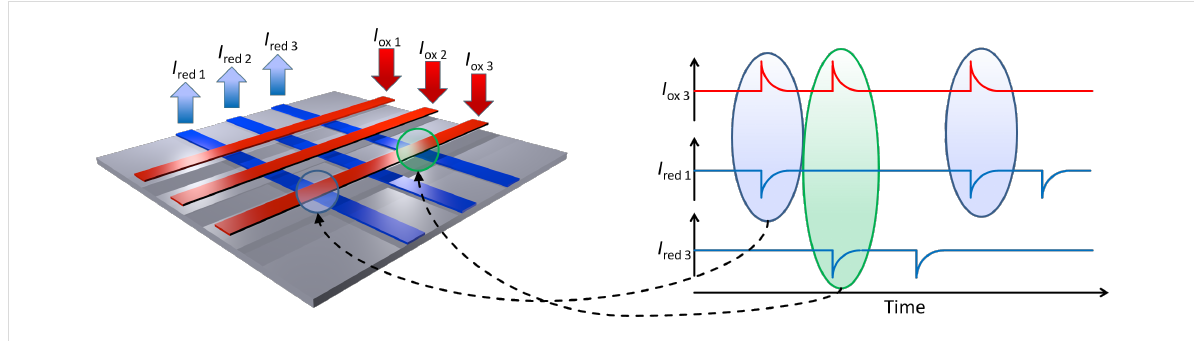
Figure 5: Illustration of a future electrochemical setup for parallel spike recording on-chip. By correlation of individual spike events at anodic and cathodic electrodes, all electrodes intersections can be read out simultaneously.